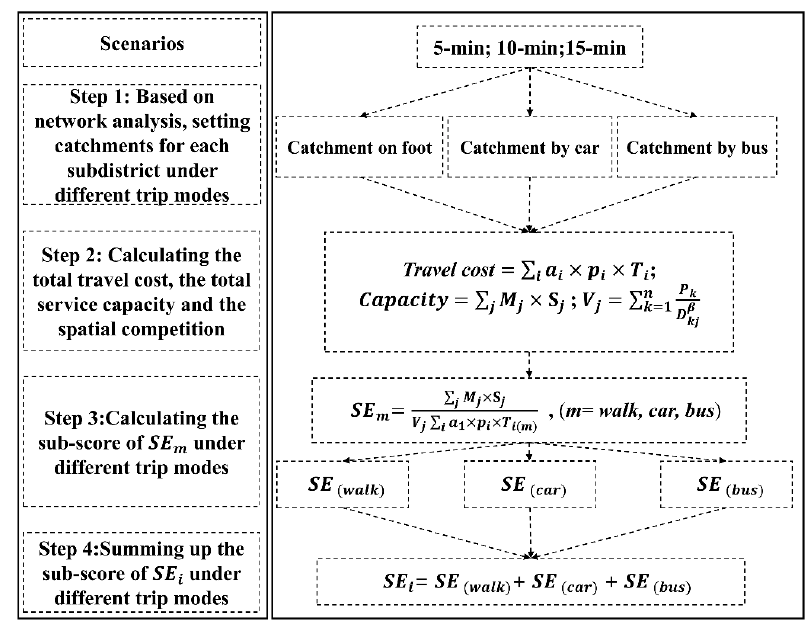
Figure 3. The technical details and analysis steps.